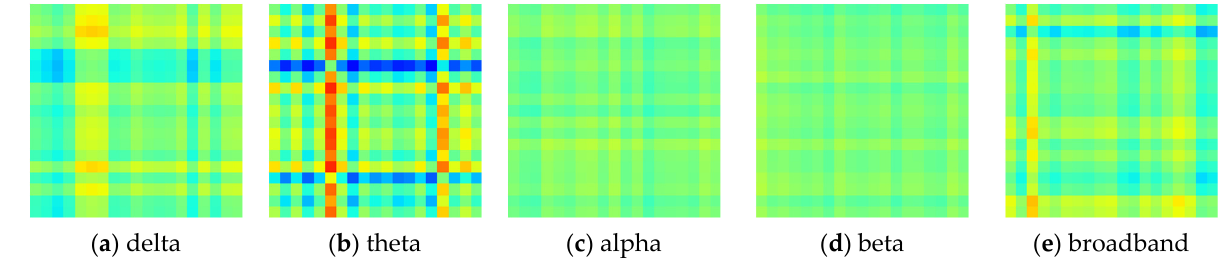
Figure 8. Example of minimal sample (BDI score is 0)’s deep-asymmetry image by each band.